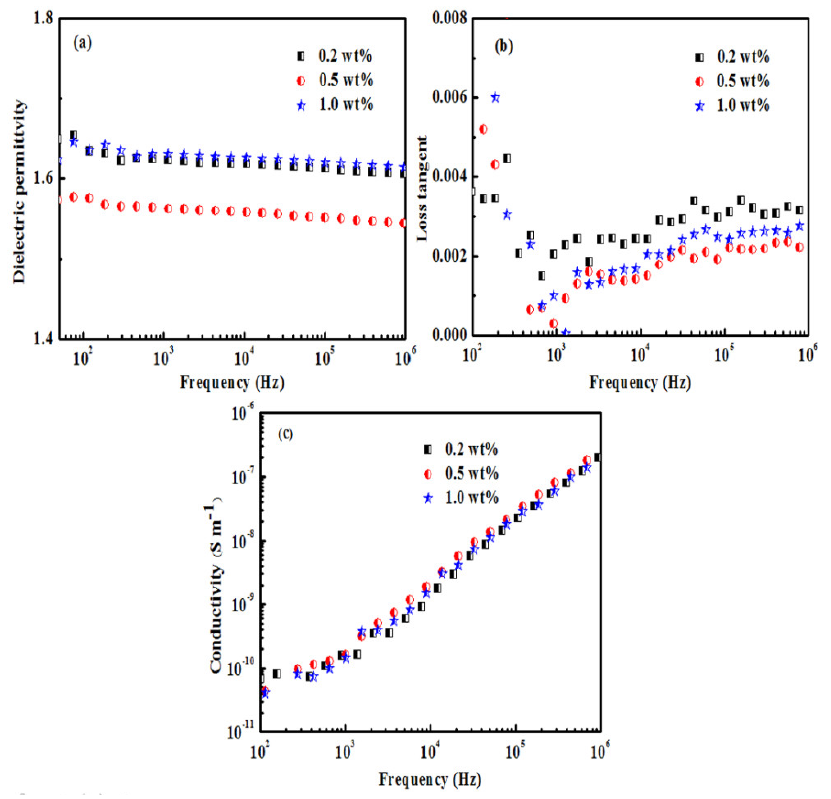
Figure 5. Dielectric properties of the different porous PI films: ( a ) dielectric constant, ( b ) loss tangent, ( c ) conductivity.